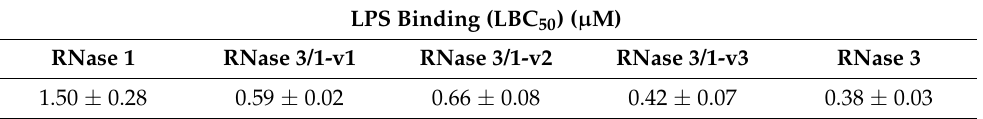
Table 3. LPS-binding affinity and liposome leakage activity of RNases 1, 3 and 3/1. The LPS concentration that displaced 50% of the bound fluorescent probe (LBC 50 ) has been determined from a dose-response curve adjusted by OriginPro 8 statistical software (Origin Lab, Northampton, MA, USA). Experimental data plots are shown in Figure S3. LPS Binding (LBC 50 ) ( µ M) RNase 1 RNase 3/1-v1 RNase 3/1-v2 RNase 3/1-v3 RNase 3 1.50 ± 0.28 0.59 ± 0.02